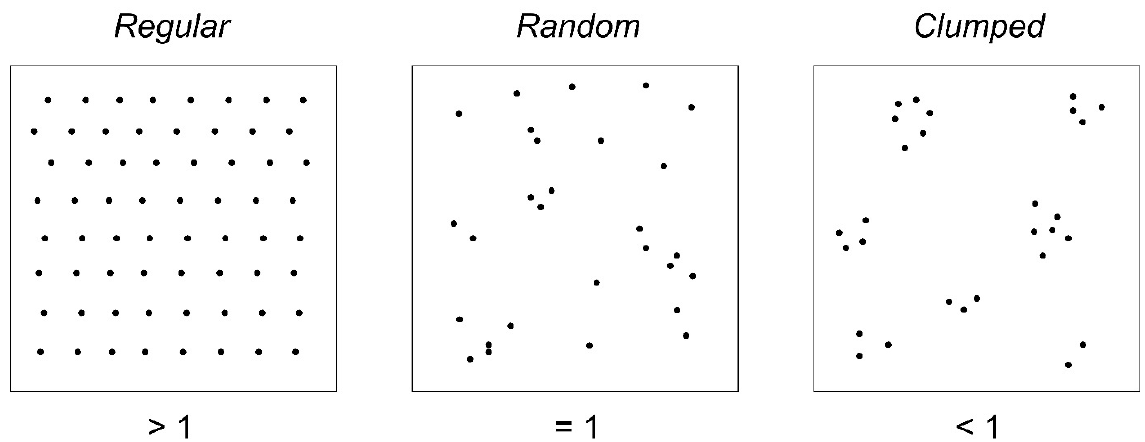
Figure 2. Spatial distributions of a population according to the three possible ranges of the R aggregation index.